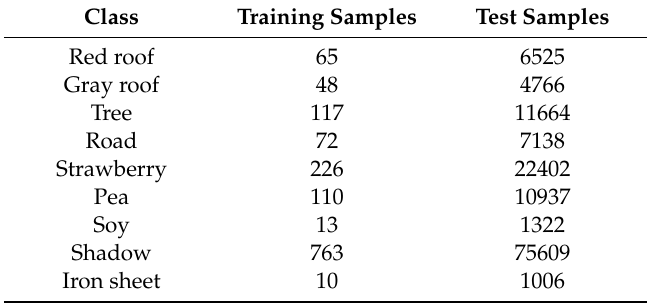
Table 2. The training and test sample information for the Hanchuan